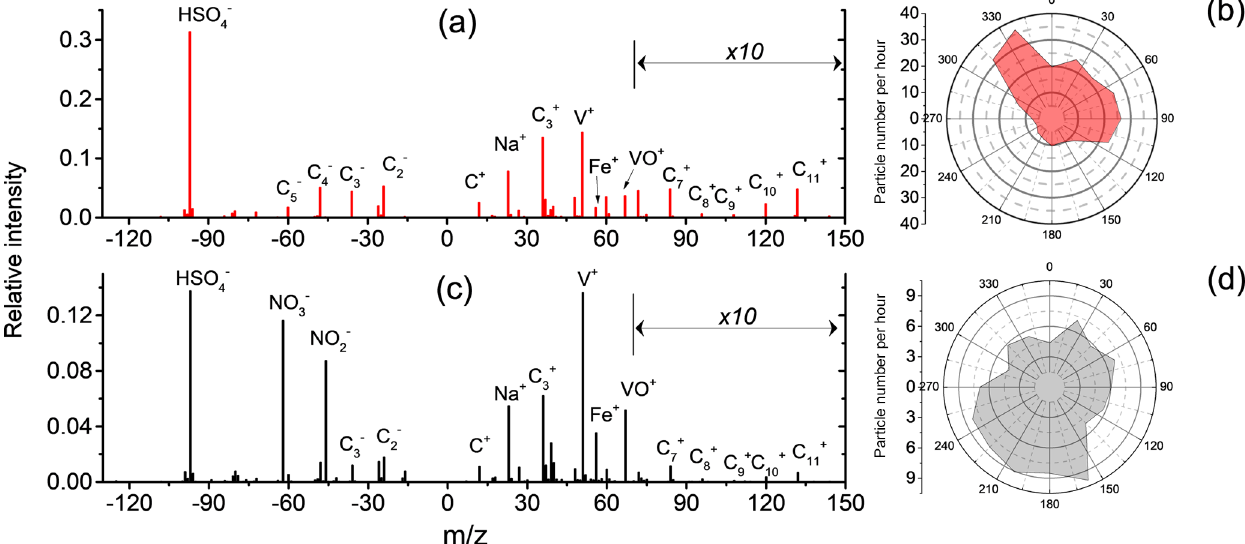
Figure 4. Mean mass spectra of fresh and background ship emission particles in port (a, c) ; wind rose diagrams of the particle number concentration (in particle number per hour) of these two particle types (b, d) . Peaks in the mass range of 70–150u in panels (a) and (c) are magnified 10 times.